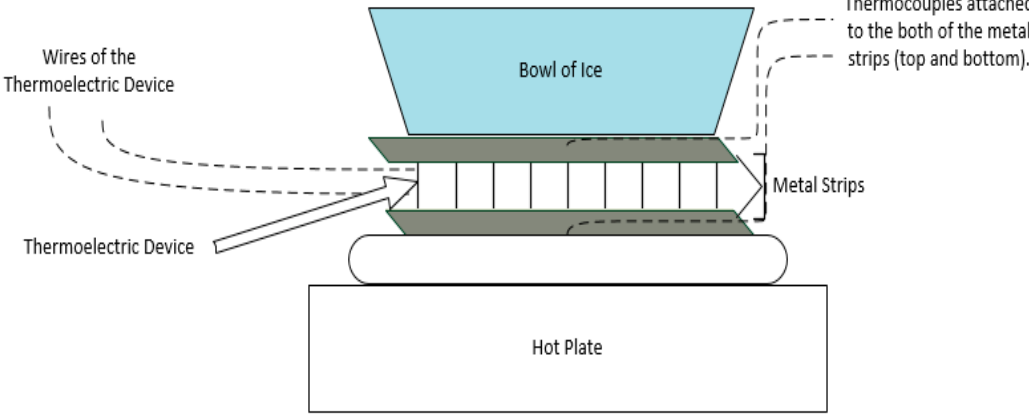
Figure 4. Schematic diagram of the direct heat harvesting method using Peltier TEG module connected with heat sink and ice-cooling to achieve larger temperature variance.